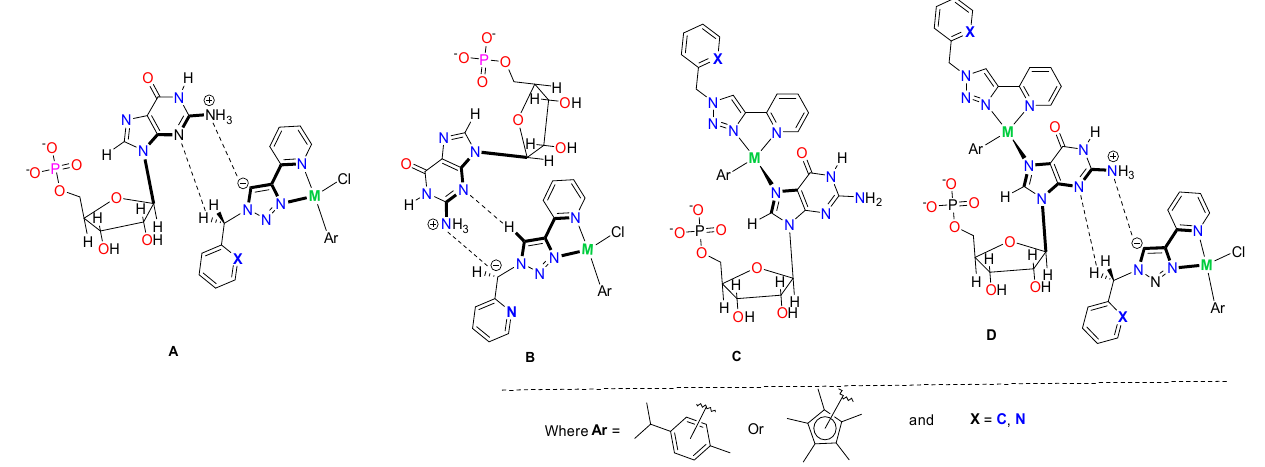
Figure 5. Proposed species ( A – D ) formed from the interaction between C1 , C5 and C11 .